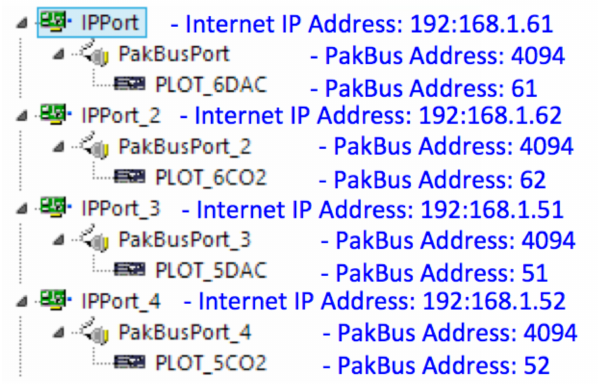
Figure 3. Example PakBus and IP addresses assigned at experimen- tal site.